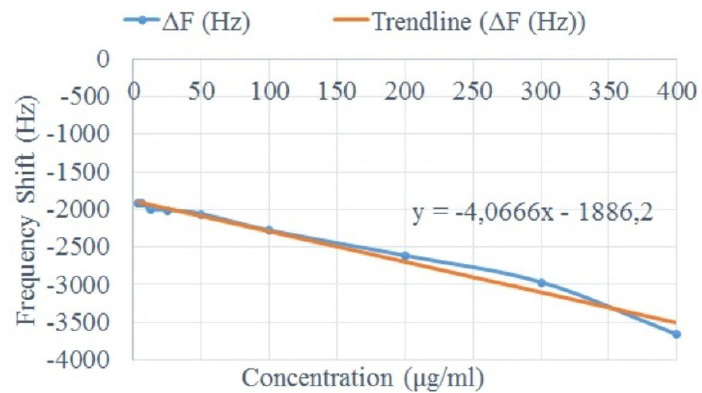
Figure 7. Response curve— ∆ f vs. Concentration of the glycerol samples (Newtonian behavior).